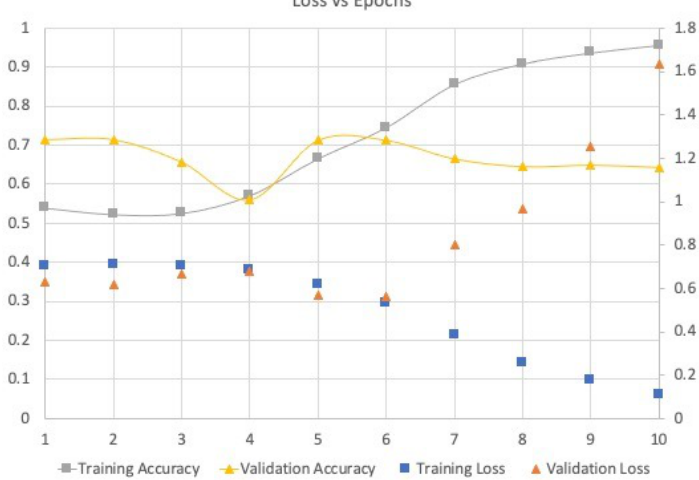
Figure 1. Training and validation loss vs. number of epochs.